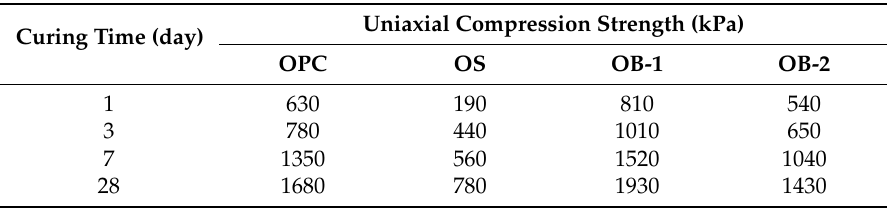
Figure 6. Uniaxial compression strength graphs for the improved OPC. Table 4. Uniaxial compression strength of the improved OPC.